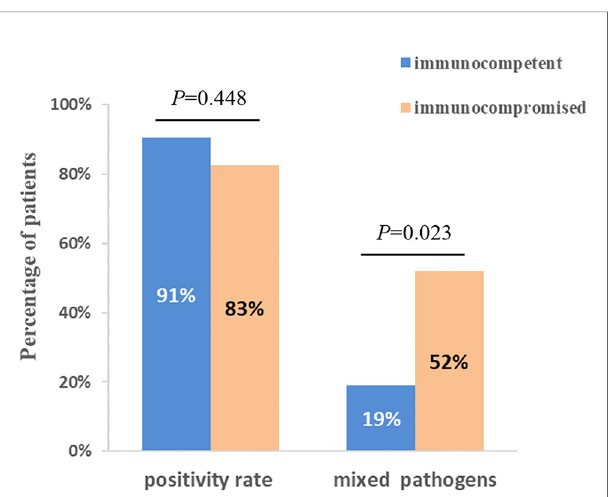
FIGURE 2 | Comparison of positivity rate and detection of mix pathogens based on mNGS test between immunocompetent and immunocompromised patients. There was no signi fi cant difference between two groups when compared with positivity rate ( P =0.448). 12 patients (52%) of immunocompromised patients were identi fi ed as mixed pathogen infection based on mNGS results, which were 4 (19%) in immunocompetent patients ( P =0.023).